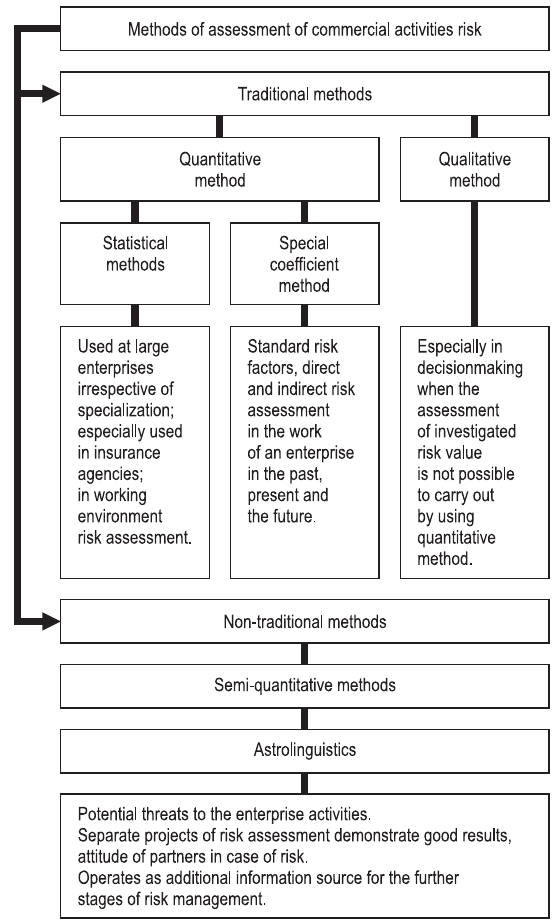
Fig. 1 . Most frequently used methods of the assessment of the risk of entrepreneurial activities and spheres of their application (Pettere, Voronova